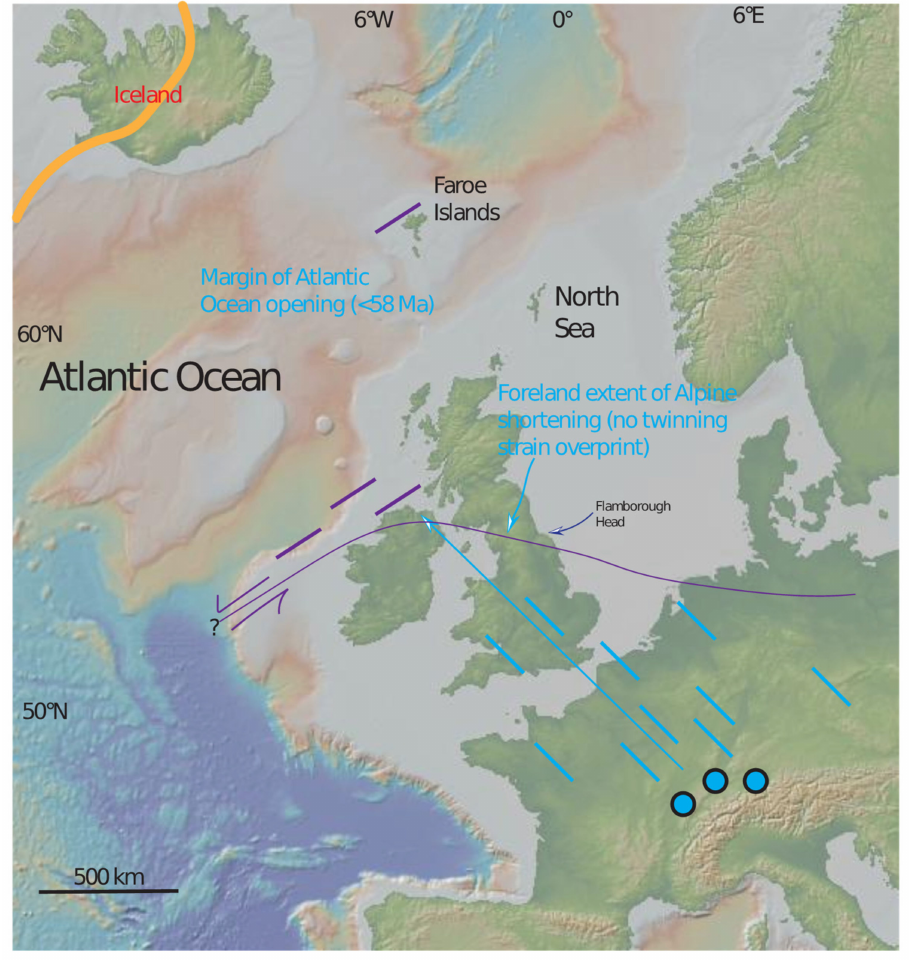
Figure 12. Northwestern Europe with the Mid-Atlantic Ridge (orange line) defining the active divergent margin. Calcite twinning strain axes are presented by color (oldest to youngest): opening of the Atlantic Ocean (58 Ma; purple), and Alpine shortening (30 Ma, blue). Faroe Islands data from Roberts and Walker (2016) with Atlantic opening calcite ages ranging from 44–37 Ma. Flamborough Head preserves deformation ~63–55 Ma Roberts et al. [129]. Key: Colored lines represent layer- parallel shortening, circles are layer-normal shortening in the Alpine nappes (Table 2, Figures 7 and